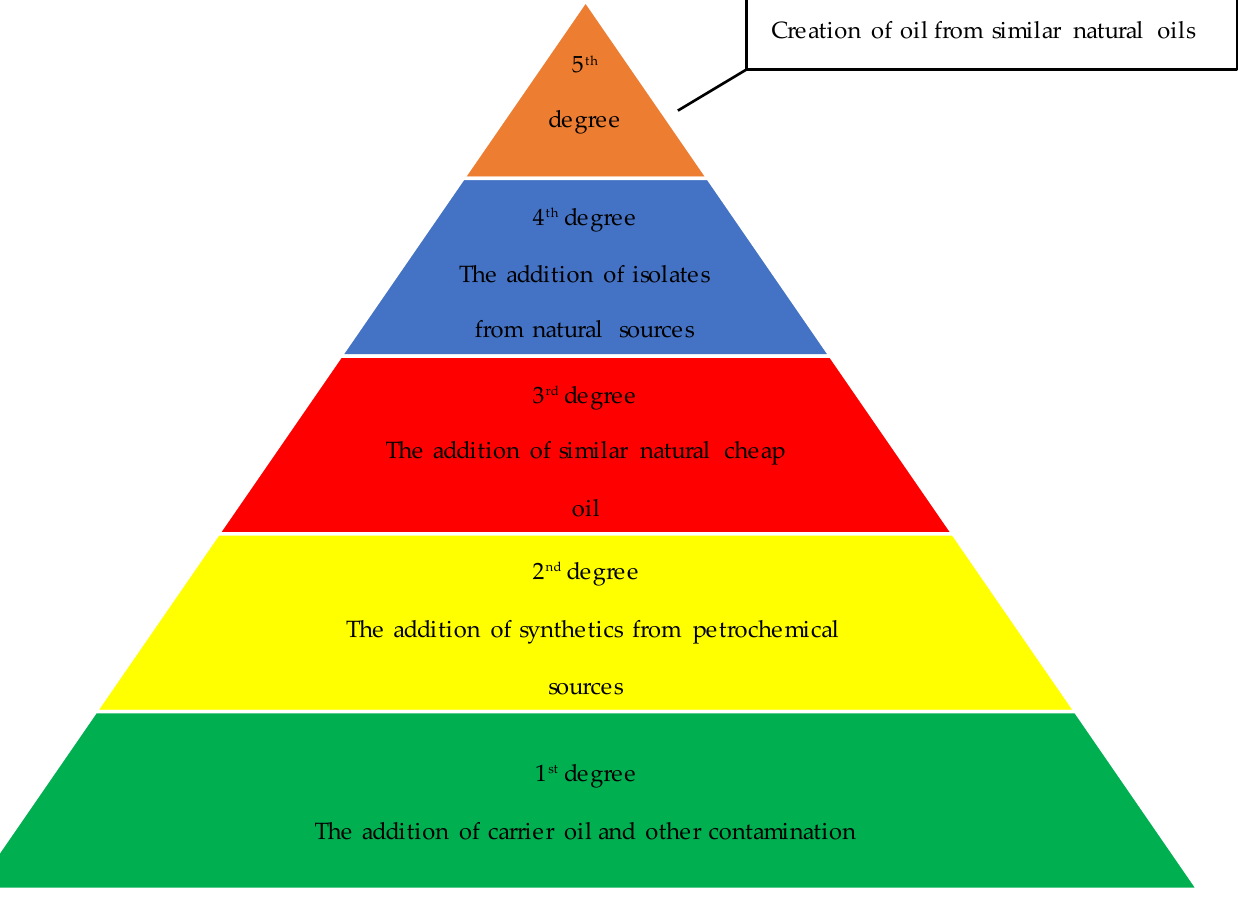
Figure 1. Different degrees of essential oil adulteration.